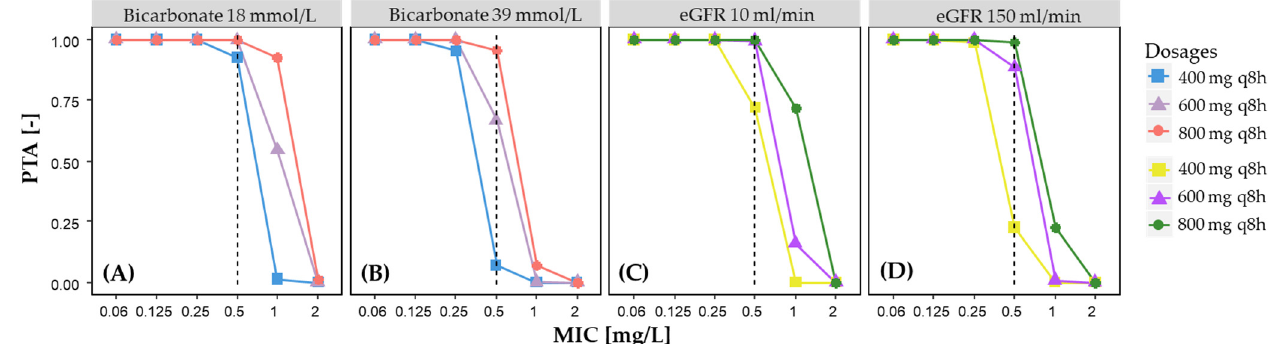
Figure 4. The impact of three different dosing regimens on the PTA, depending on ( A ) the lowest bicarbonate, ( B ) the highest bicarbonate, ( C ) the lowest eGFR, and ( D ) the highest eGFR values in the study population and the respective MIC value. The dashed vertical line represents the breakpoint of 0.5 mg/L. A PTA ≥ 90% was considered satisfactory.